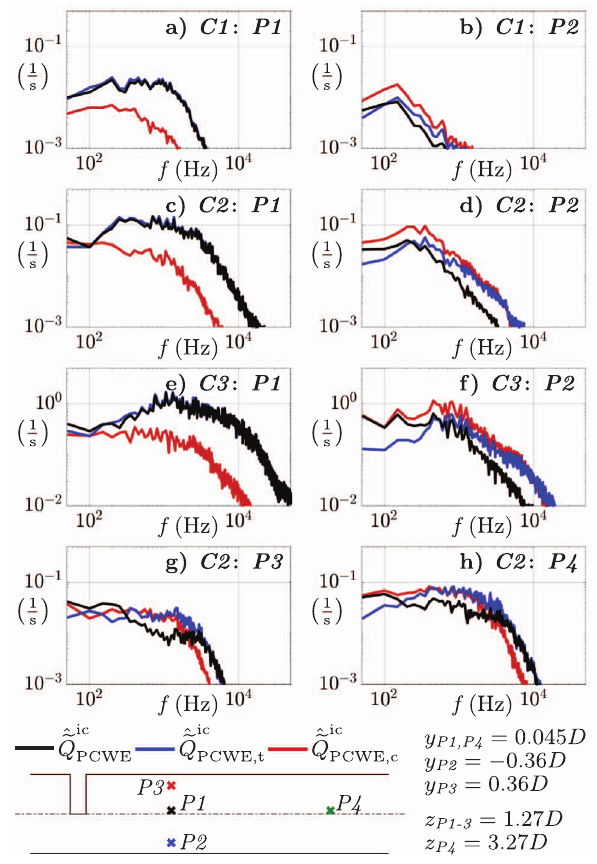
Figure 10. Spectra of the PCWE source term and its compo- nents within the high turbulent region ( P 1) and the high- velocity region ( P 1) marked in the bottom sub fi gure, for (a) and (b) C 1, (c) and (d) C 2, (e) and (f) C 3, respectively. Additional spectra for C2 inside the (g) recirculation zone and (h) further downstream of the high turbulent region ( P